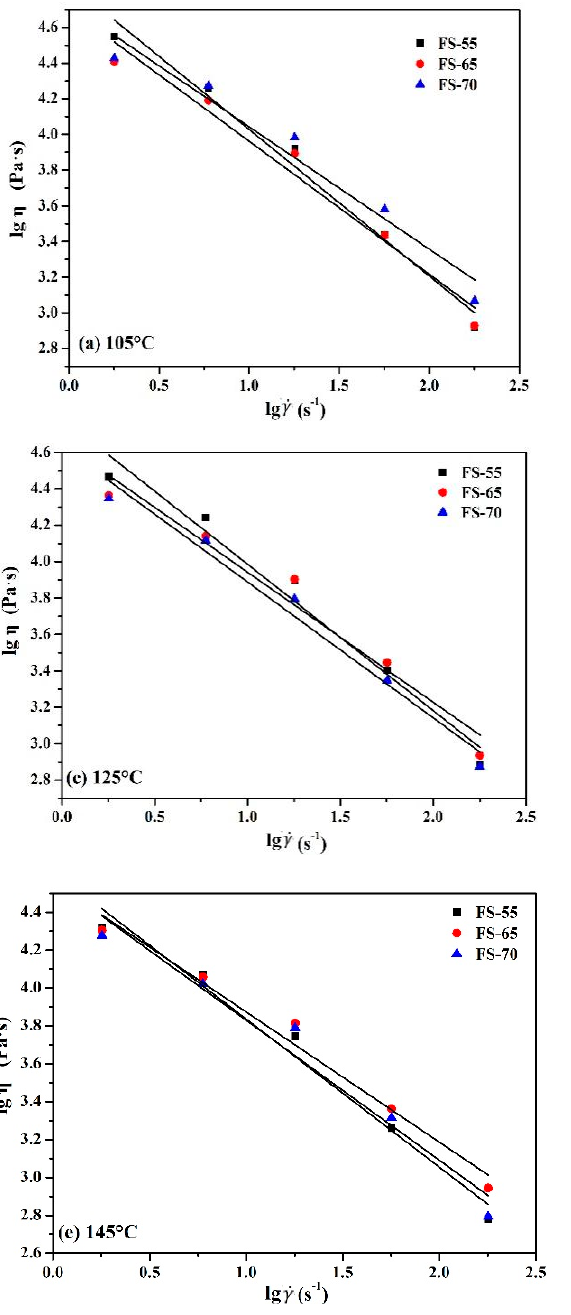
Figure 3. Shear rate dependence of viscosity ( a – e ) and values of n ( f ) at various temperatures. The changing of n at various temperatures for three kinds of feedstocks is present in Figure 3f. It shows that n value of FS-55 is the highest at temperature range 105–145 ◦ C, meaning a more stable viscosity to shearing rate than that of other feedstocks. This might be correlated to its highest amount of polymer composition (HDPE + EVA). At the same time, maximum n value emerges at 105 ◦ C, which means it is more stable at lower temperature. For the FS-65, the n value first increases till the maximum is reached at 115 ◦ C and then it shows a decreasing tendency as the temperature further increases. Therefore, the FS-65 is most resistant to shearing at 115 ◦ C. The n value of the FS-70 exhibits a similar trend as the FS-65, but the temperature to yield a peak value is 125 ◦ C and thereby at such a temperature the FS-70 is expected to be most